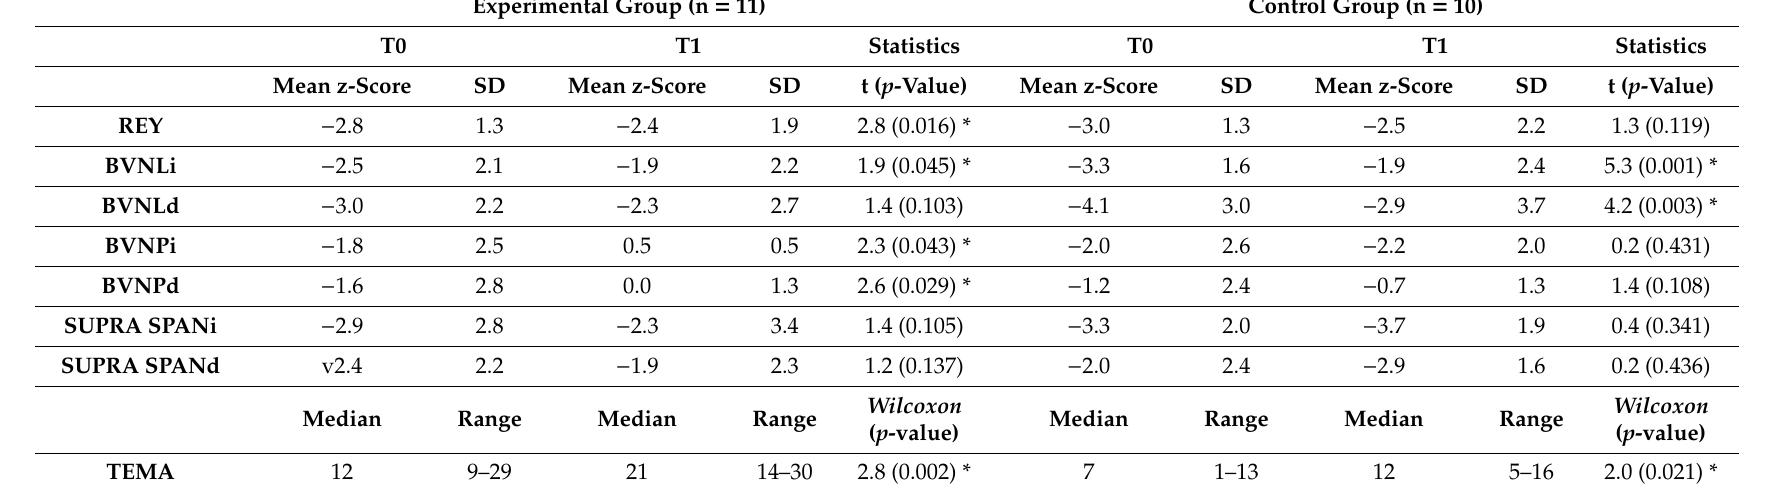
Table 3. Scores at the neuropsychological tests, before (T0) and after (T1) rehabilitation. Experimental and Control groups are reported in separate columns. Abbreviations indicate the Rey-Osterrieth complex figure test (REY), the test for immediate and delayed memory of a list of words of the Italian BVN battery (BVNLi and BVNLd, respectively), the test for immediate and delayed recall in prose memory of the Italian BVN battery (BVNPi and BVNPd), the test for immediate and delayed recall in positional memory supra-span (SUPRASPANi and SUPRASPANd), and the Italian TEMA test for the learning of couples of related and unrelated words